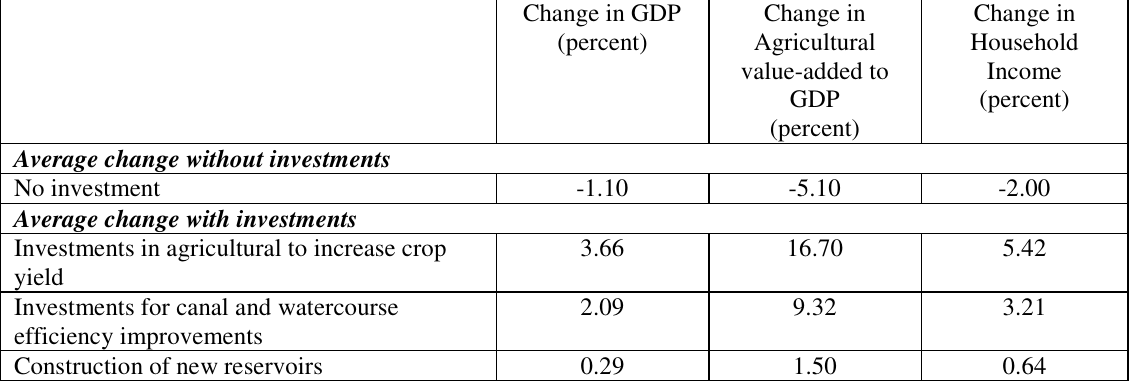
Change in GDP (percent)